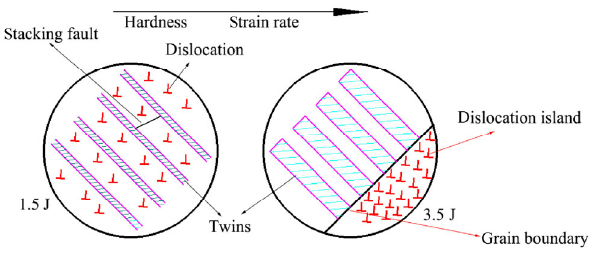
Fig. 8 Schematic summarizing the feature of twins and dislocation at different impact